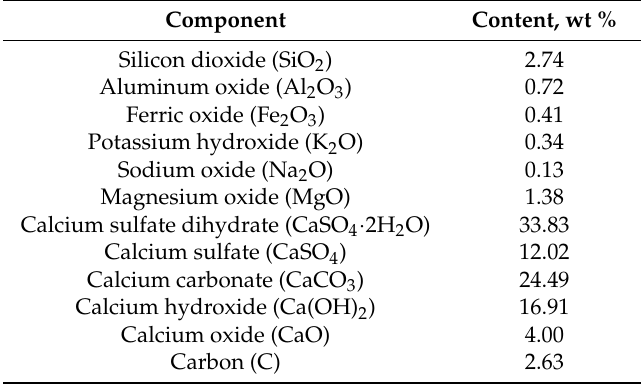
Table 1. Composition of CFBC hydrated